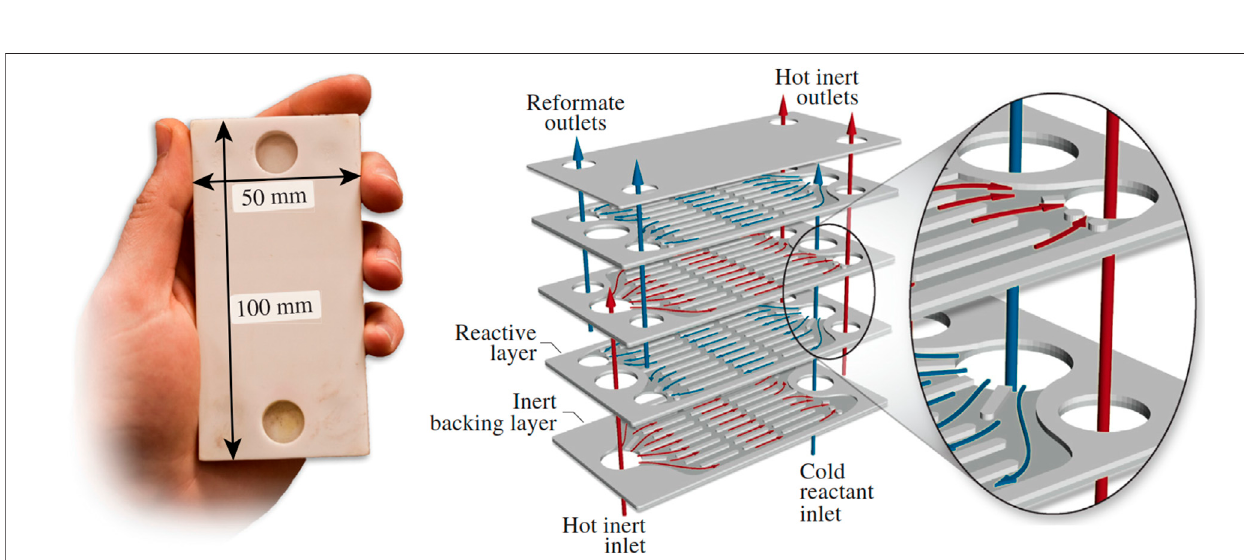
Frontiers in Chemical Engineering |